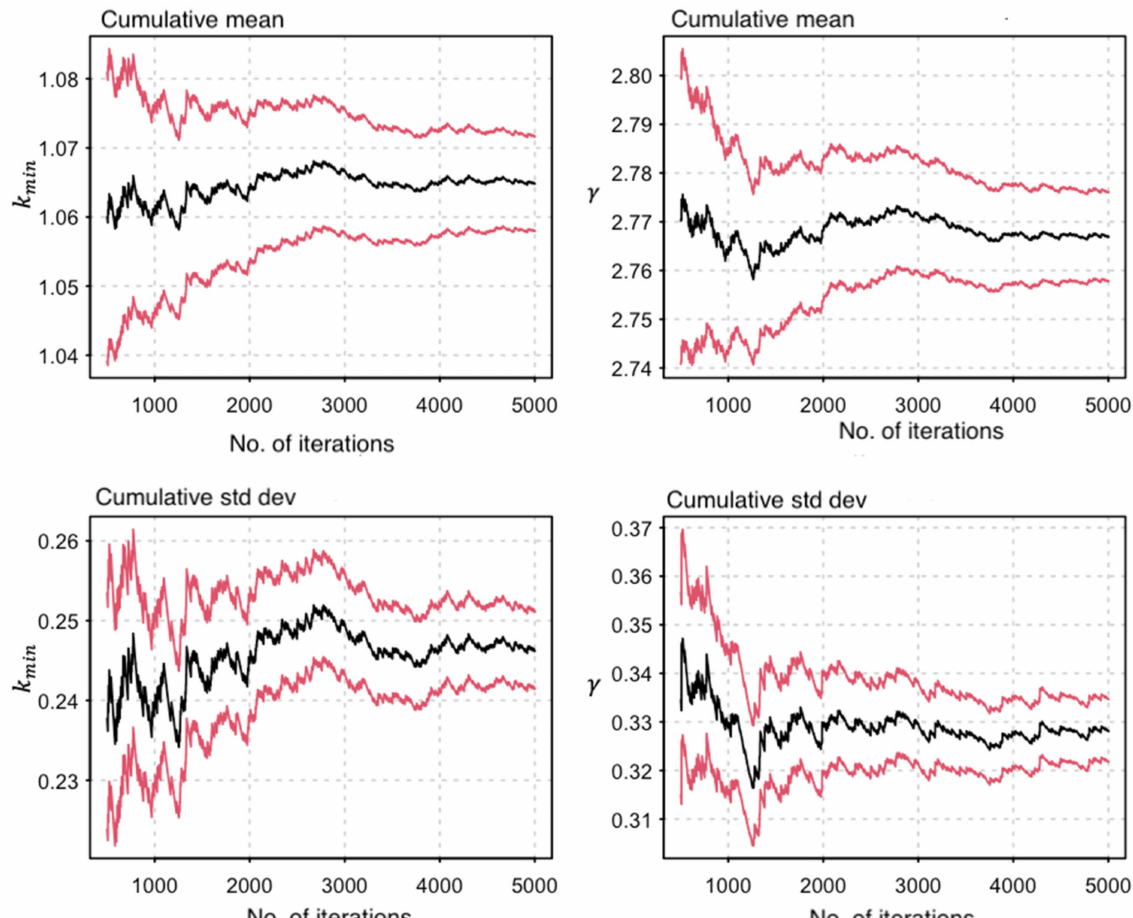
Figure 2. A graph showing the bootstrap resampling of parameter estimates. Panels show the cumulative mean and standard deviation (SD) of γ and k min , respectively. In both panels, the vertical scale represents the parameter estimates and the horizontal scale represents the number of bootstrap iterations while the black and the red lines represent the mean and 95% CI intervals,